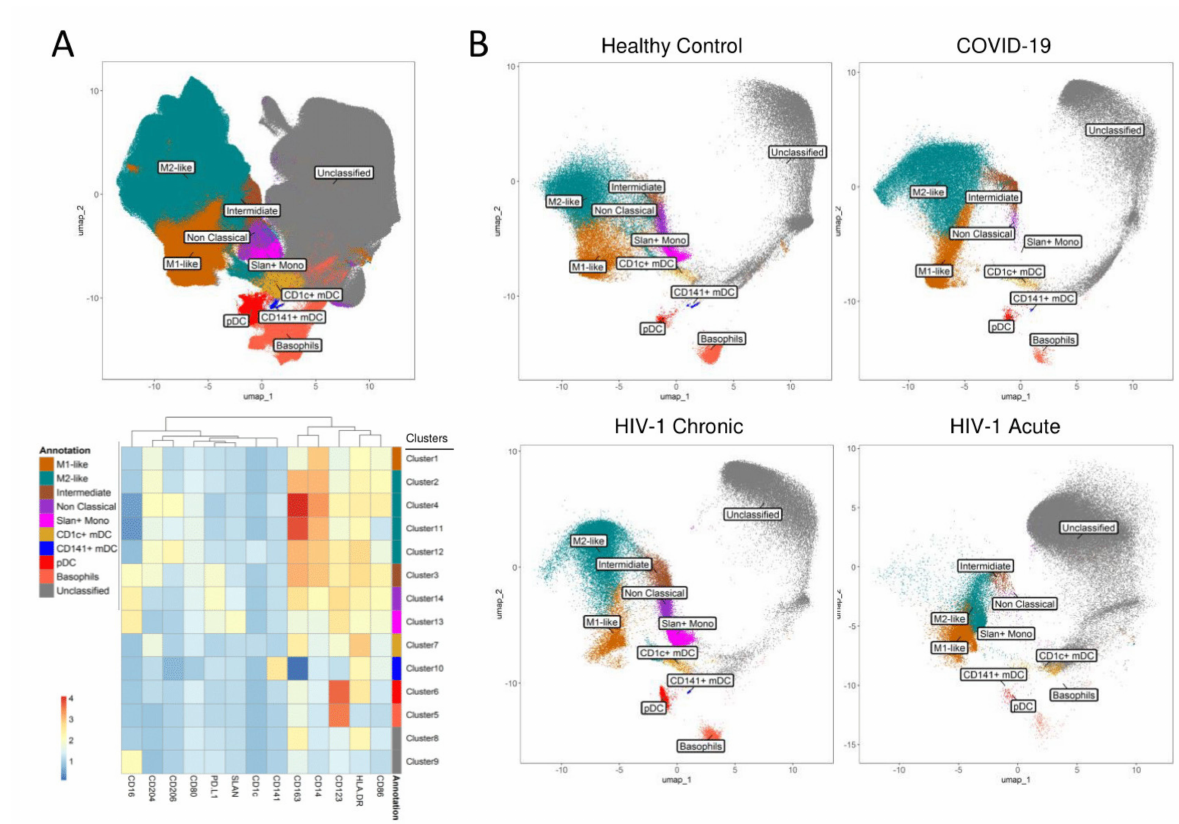
Figure 1. Profiling of the mononuclear cells compartment in HIV-1 and SARS-CoV-2 infections using unsupervised analysis. ( A ) UMAP of the CD45 + Lin − dataset of all samples with the heatmap showing relative marker expression of the clusters obtained with the FlowSOM clustering algorithm and the manual annotation of the main subsets. ( B ) Relative subset distribution in representative individuals from the healthy control and COVID-19 groups, as well as in the untreated HIV-1 acute and HIV-1 chronic